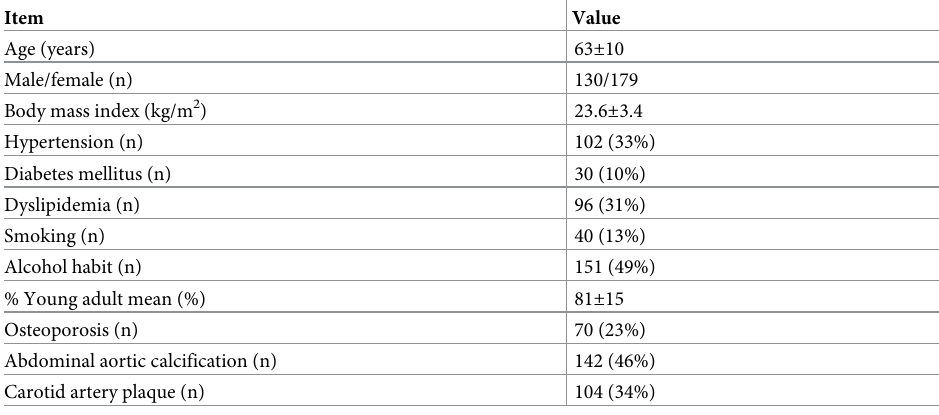
Table 2. Clinical background of the subjects (n =